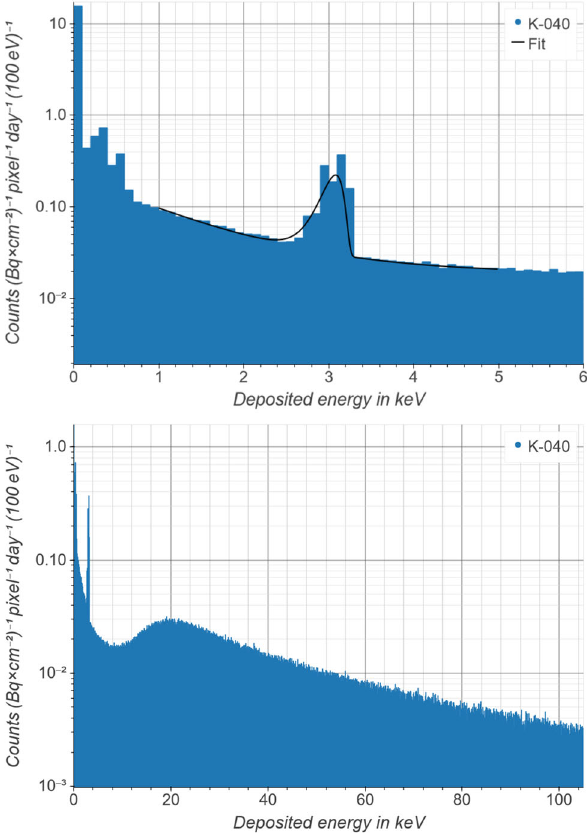
Fig. 8 Simulated spectrum of deposited energies in the MMC absorbers caused by the surface-distributed 40 K on the absorbers. The Ar lines are visible. But, in comparison to bulk contamination, they are broader, because not all X-ray and Auger electrons have to be emitted to the absorber